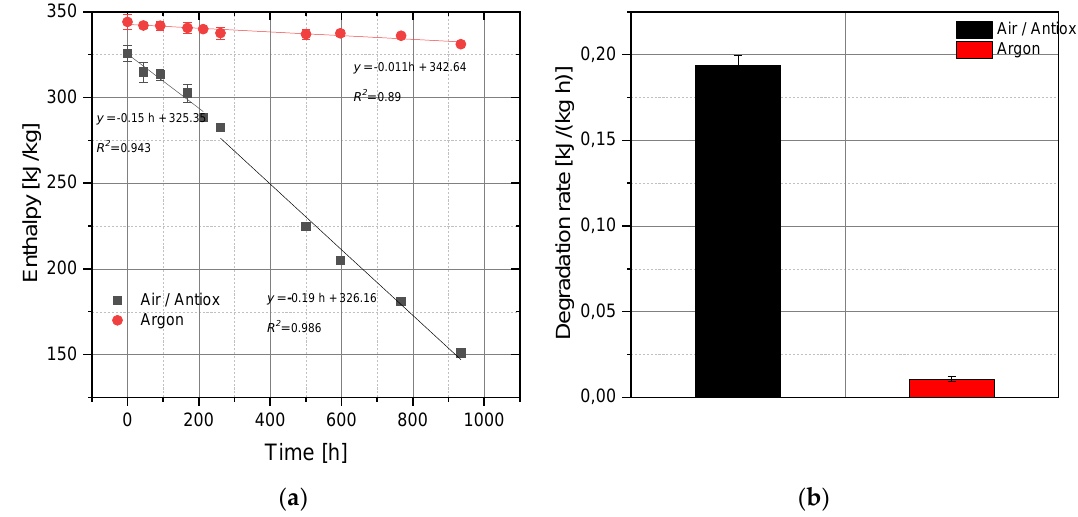
Figure 4. ( a ) Evolution of latent heat values over time during long‐term experiments at 141 °C. ( b ) Latent heat degradation rate for long-term experiments at 141 °C.